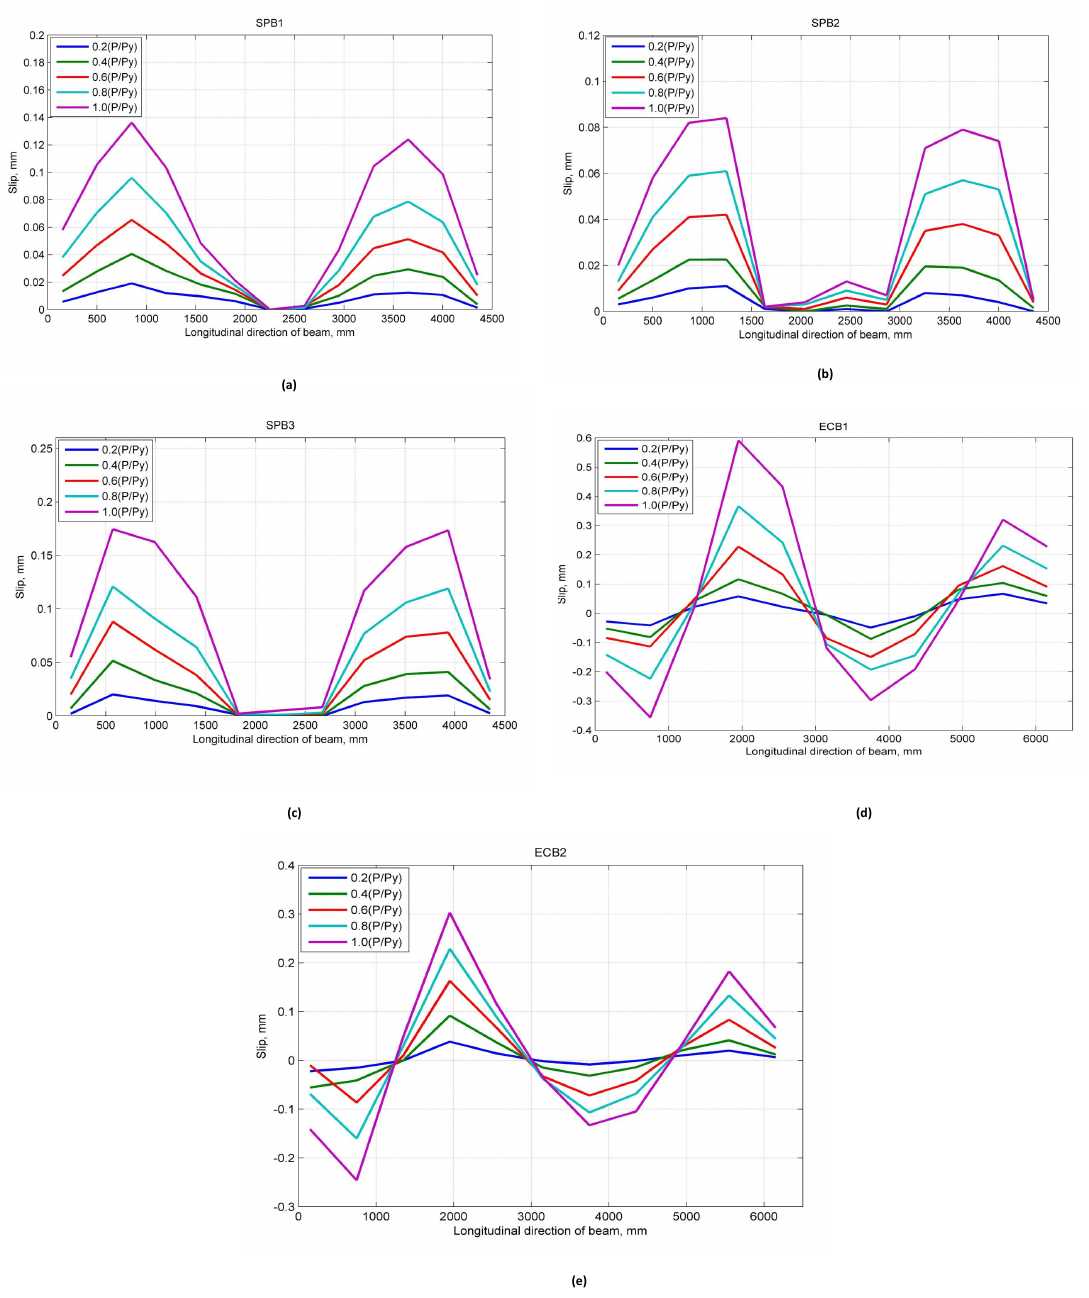
Figure 5. Variation of measured interface slip with a longitudinal direction of the beam under the action of vertical loads: ( a ) SPB1; ( b ) SPB2; ( c ) SPB3; ( d ) ECB1; ( e )